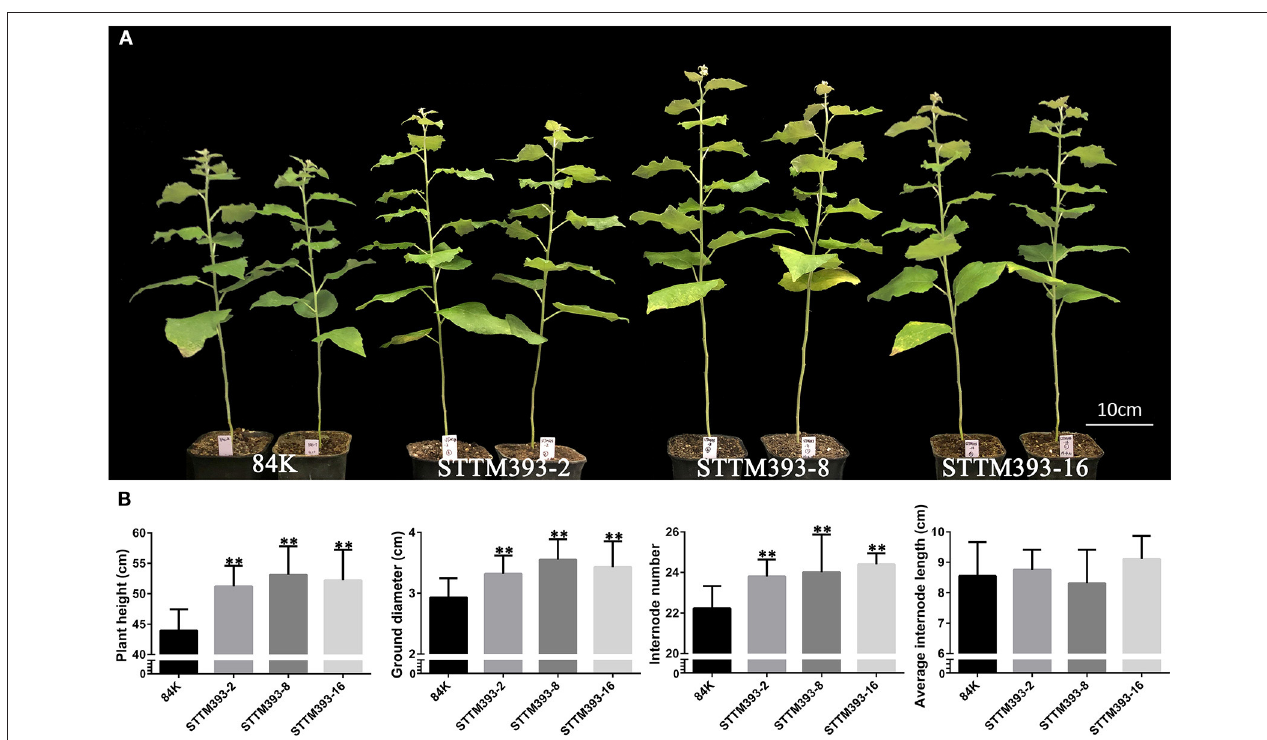
FIGURE 1 | The phenotypes of STTM393 transgenic plants. (A) 3-month-old STTM393 and 84K control plants. (B) The height, ground diameter, internode number, and average internode length of 3-month-old STTM393-2, STTM393-8, STTM393-16, and 84K control plants. The bars represent means ± SD ( n = 10), ** P ≤